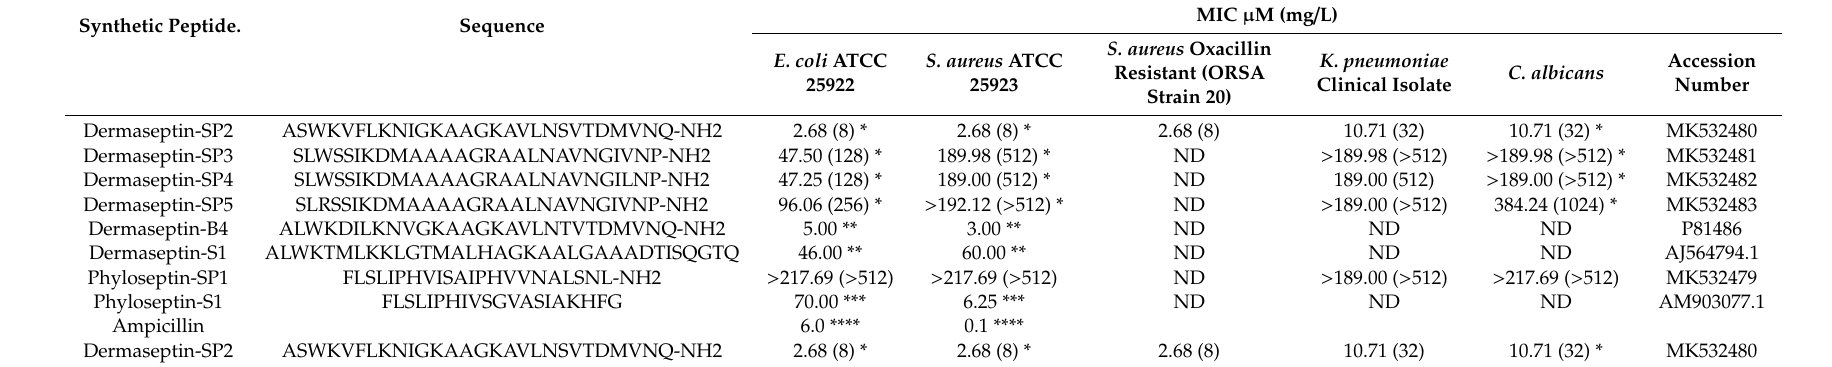
Table 2. Minimal inhibitory concentrations (MICs) of synthetic dermaseptins and phylloseptin-SP1 of Agalychnis spurrelli. Synthetic